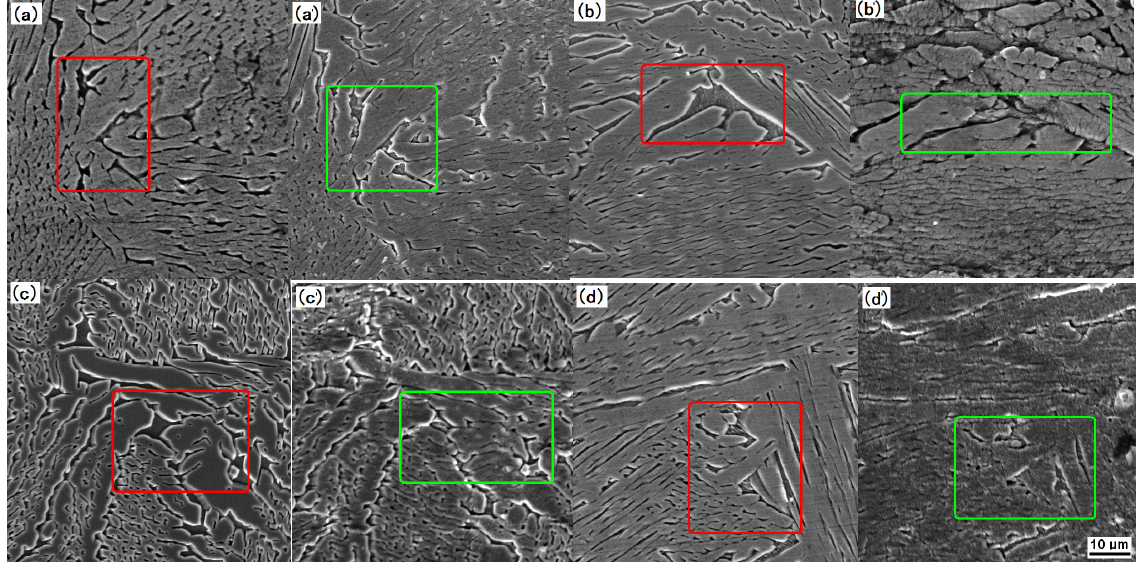
. . Figure 7. Effect of different deformation rates on flow under 400 °C and 500 °C: ( a ) ̇ 0.01, ( a’ ) ̇ 0.01 Figure 7. Effect of different deformation rates on flow under 400 ◦ C and 500 ◦ C: ( a ) ε 0.01, ( a’ ) ε 0.01 after upsetting, 400 °C; ( b ) ̇ 0.1, ( b’ ) ̇ 0.1 after upsetting, 400 °C; ( c ) ̇ 0.01, ( c’ )  ̇ 0.01 after upset- . . . . ε 0.1, ( b’ ) ε 0.1 after upsetting, 400 ◦ C; ( c ) ε 0.01, ( c’ ) ε 0.01 after upsetting, after upsetting, 400 ◦ C; ( b ) ting, 500 °C; ( d ) ̇ 0.1, ( d’ )  ̇ 0.1 after upsetting, 500 °C (The red rectangles are the observation areas . . ε 0.1, ( d’ ) ε 0.1 after upsetting, 500 ◦ C (The red rectangles are the observation areas before 500 ◦ C; ( d ) before deformation and the green rectangles are the observation areas after deformation). deformation and the green rectangles are the observation areas after